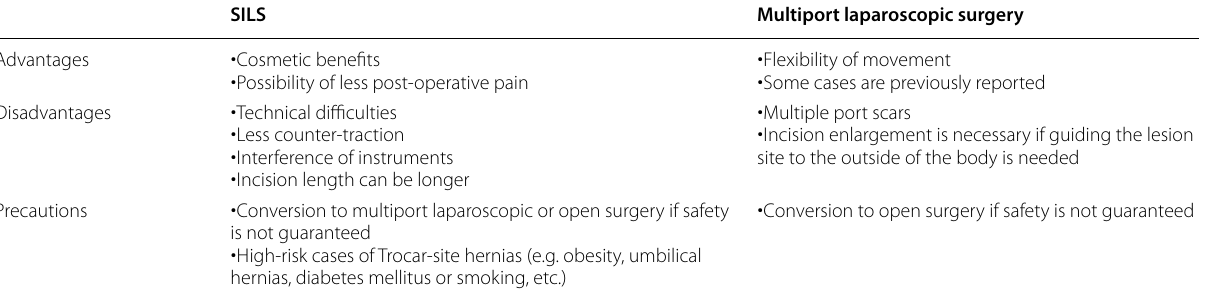
Table 1 The advantages and disadvantages of performing paraduodenal hernia by single-incision laparoscopic surgery (SILS) SILS Multiport laparoscopic